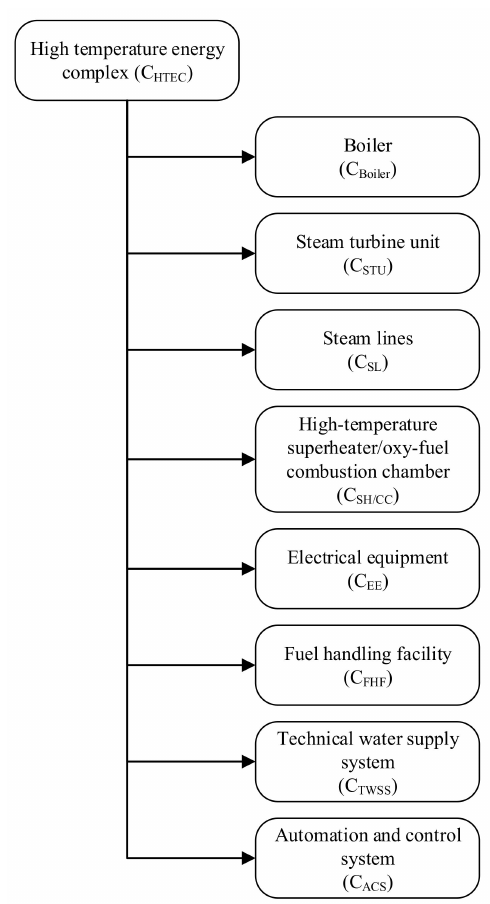
Figure 11. High-temperature energy complex cost